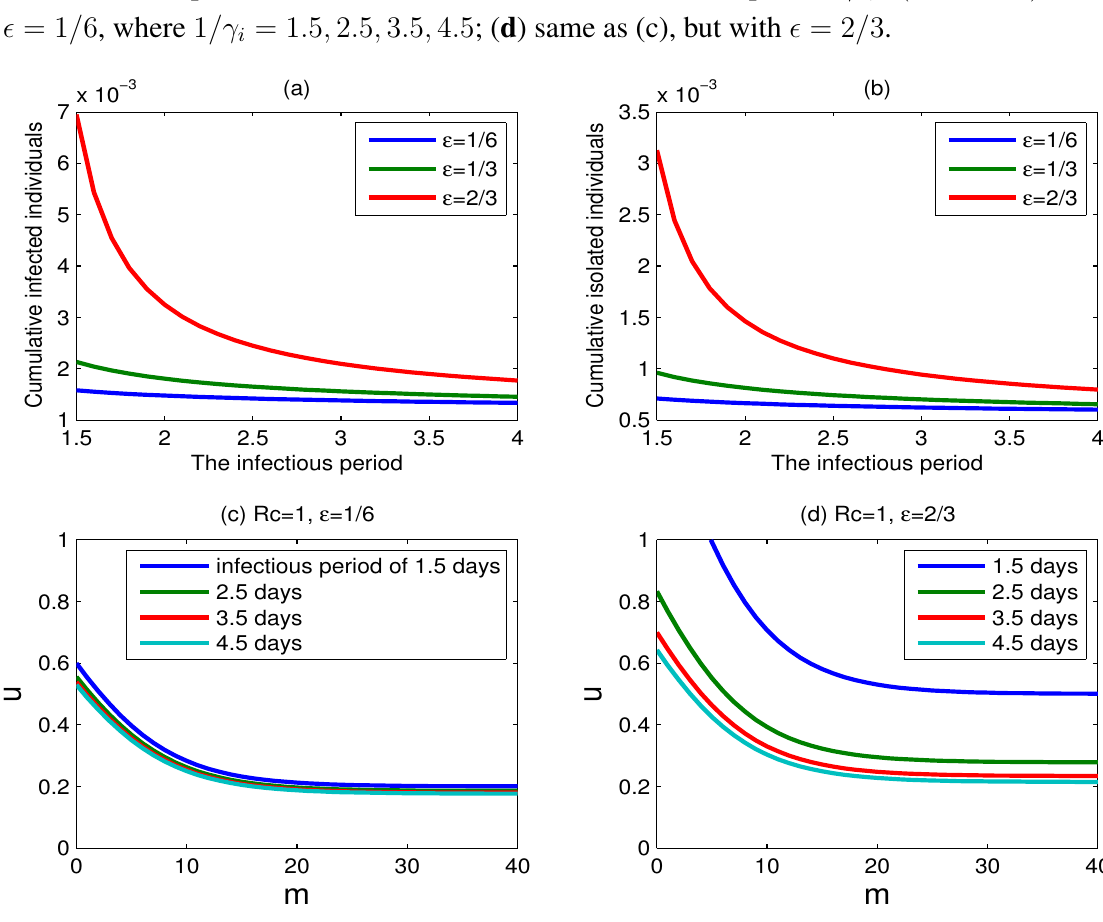
Figure 12. The effect of varying parameters determining infectious period. ( a ) Plots of the cumulative percentage of infected individuals as functions of the infectious period, for (cid:15) = 1 / 6 , 1 / 3 , 2 / 3 , respectively; ( b ) same as (a), but for the cumulative percentage of isolated individuals; ( c ) plots for which R , ( i = 1 , 2 , 3) with = 1 for different infectious period 1 /γ c i (cid:15) = 1 / 6 , where 1 /γ = 1 . 5 , 2 . 5 , 3 . 5 , 4 . 5 ; ( d ) same as (c), but with (cid:15) = 2 / 3 i